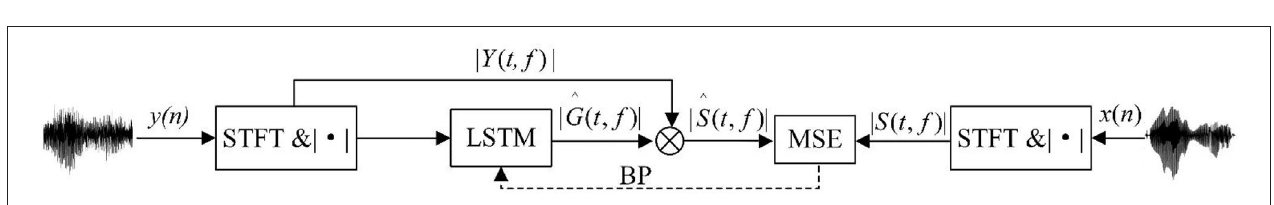
FIGURE 2 | The diagram for SE with DL-estimated T-F masking gain.